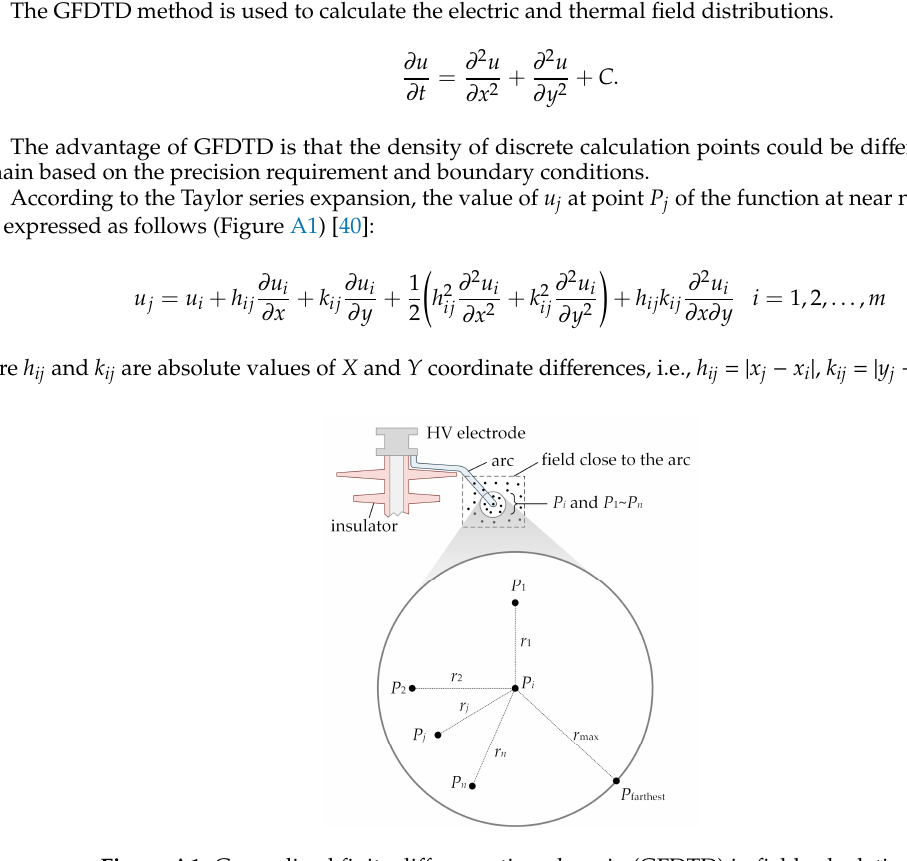
Figure A1. Generalized finite difference time domain (GFDTD) in field calculation.